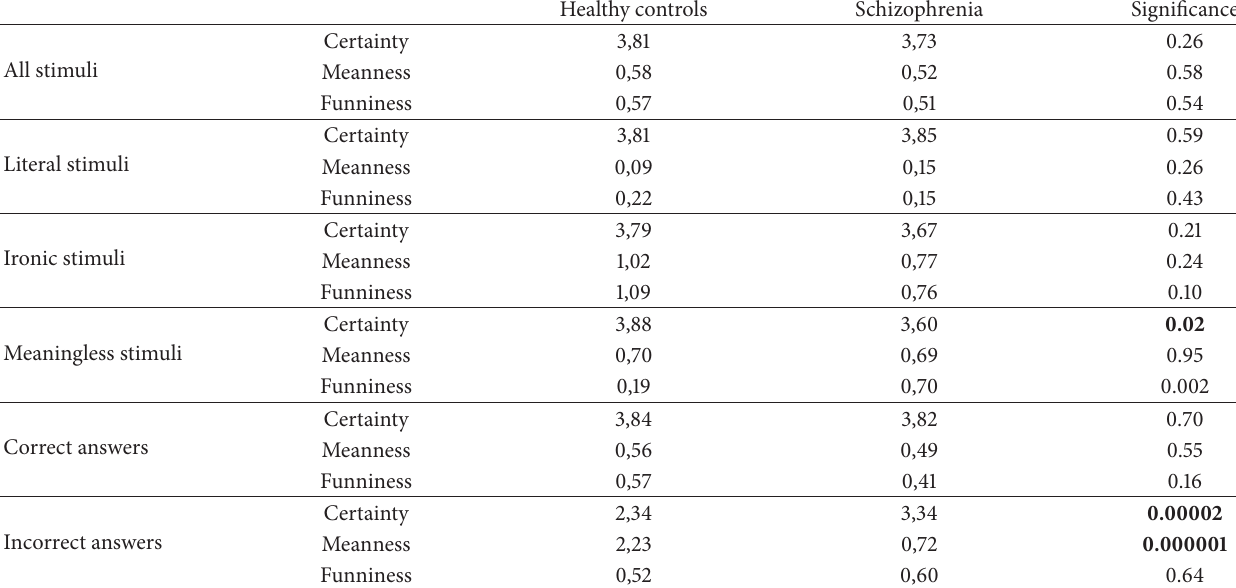
Table 2: Group differences in detection and appreciation of